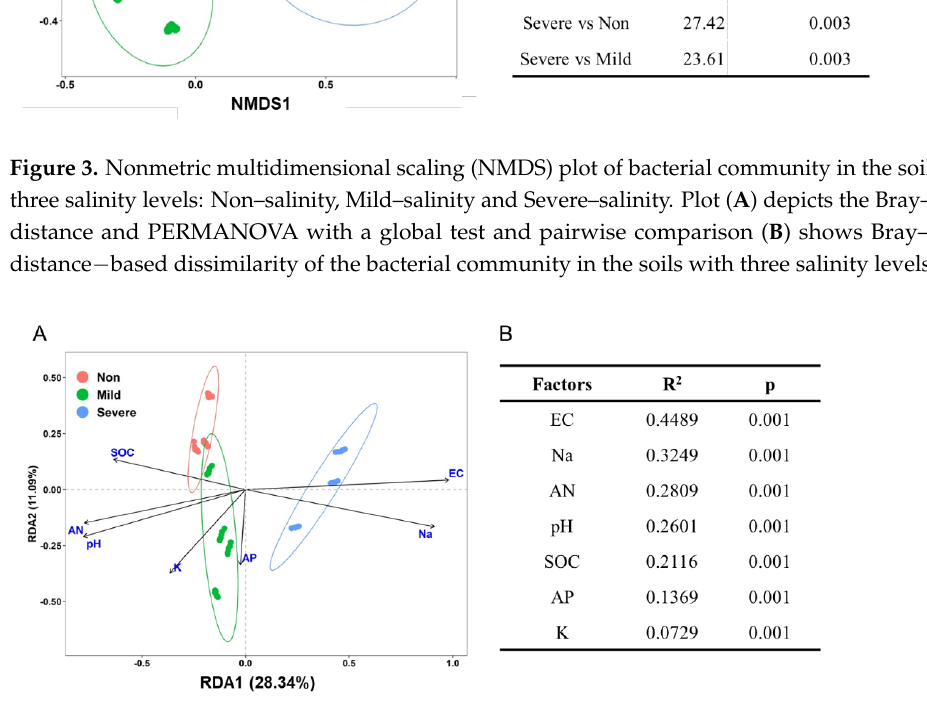
Figure 3. Nonmetric multidimensional scaling (NMDS) plot of bacterial community in the soils with three salinity levels: Non − salinity, Mild − salinity and Severe − salinity. Plot ( A ) depicts the Bray – Cur- tis distance and PERMANOVA with a global test and pairwise comparison ( B ) shows Bray – Curtis distance − based dissimilarity of the bacterial community in the soils with three salinity levels. Figure 4. Redundancy analysis (RDA) plot of the soils with three salinity levels: Non − salinity, Mild − salinity and Severe − salinity. Plot ( A ) depicts the correlation between bacterial community and soil chemical properties and Mantel test ( B ) compares the relative impacts of soil chemical properties on the bacterial community. EC: electrical conductivity; SOC, soil organic C; AP: available P; AN: available N.